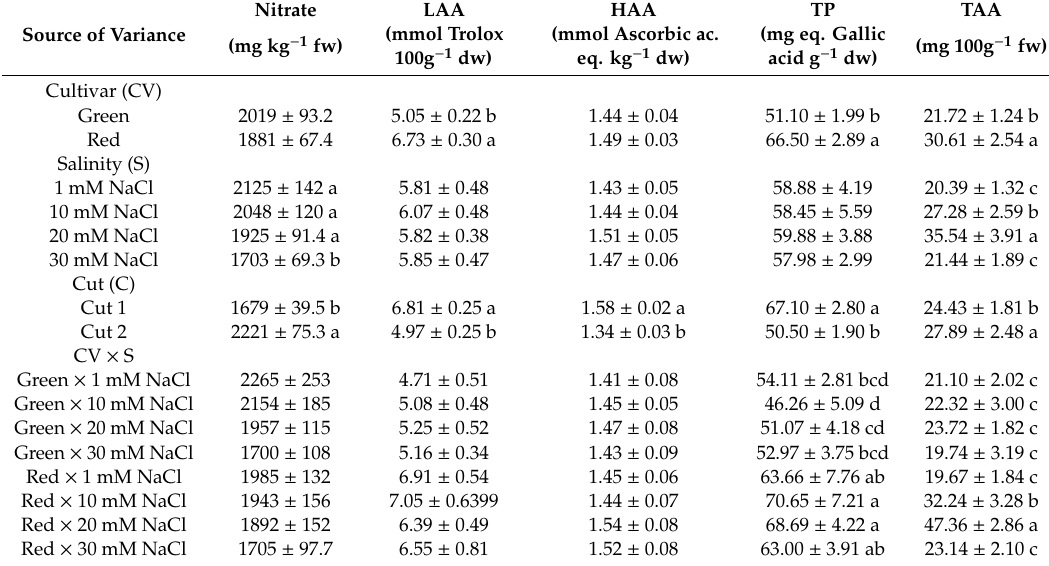
Table 4. Significance of the main factors (cultivar, salinity and cut order) and their interactions on nitrate content, lipophilic antioxidant activity (LAA), hydrophilic antioxidant activity (HAA), total phenols (TP) and total ascorbic acid (TAA) of Lactuca sativa L. var. acephala grown in a floating raft